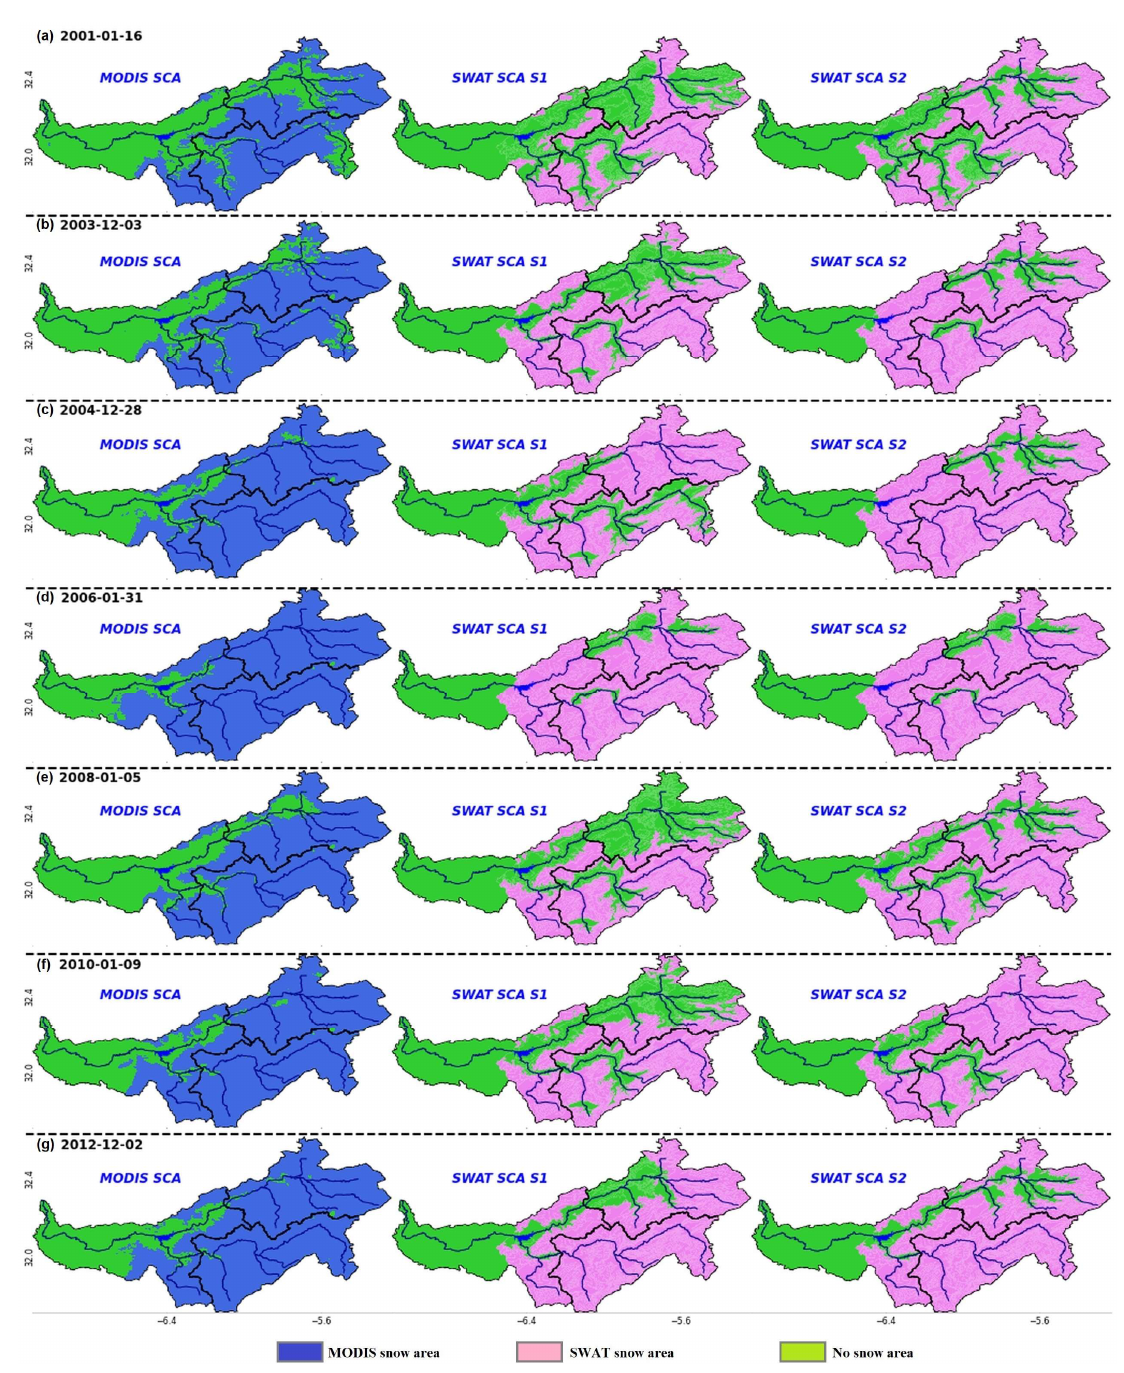
Figure 4. Snow extent visualizations for Oued El Abid catchment from MODIS and SWAT. ( a ) 16